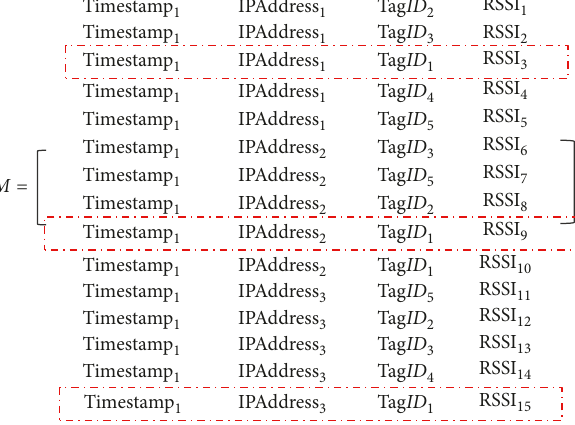
Figure 21: Organization of the two-dimensional array (application